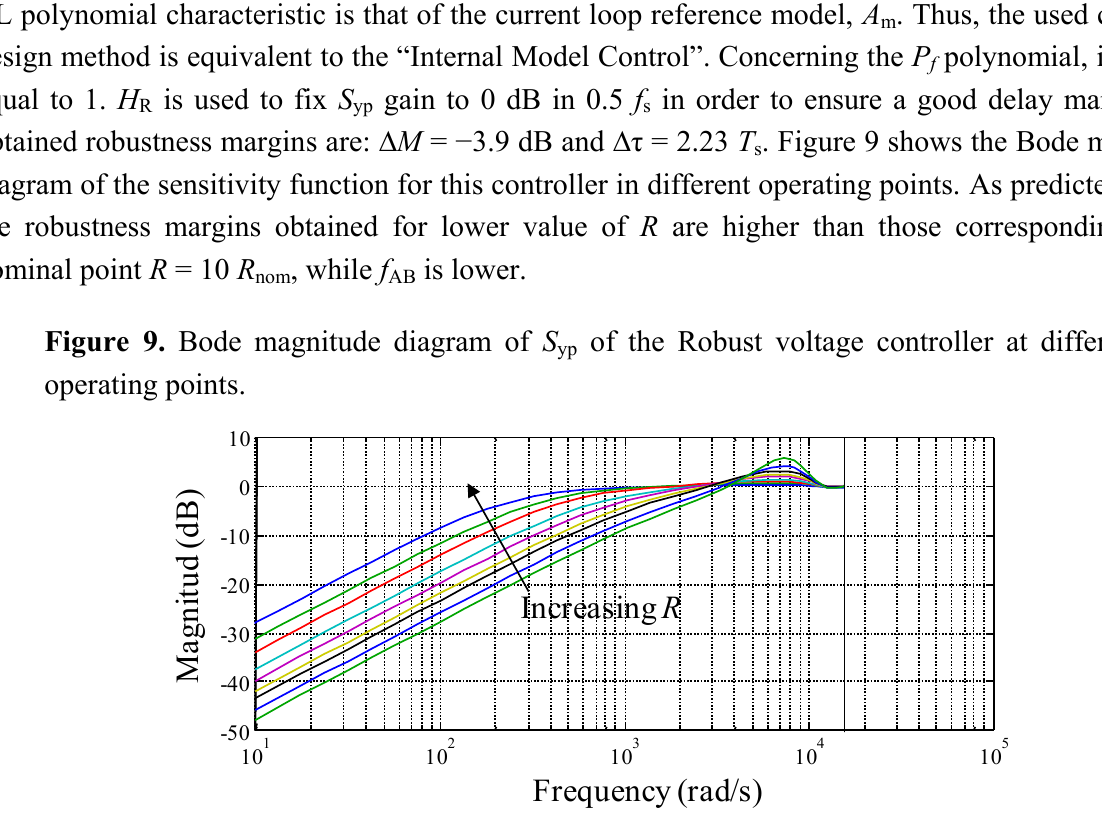
of the Robust voltage controller at different yp